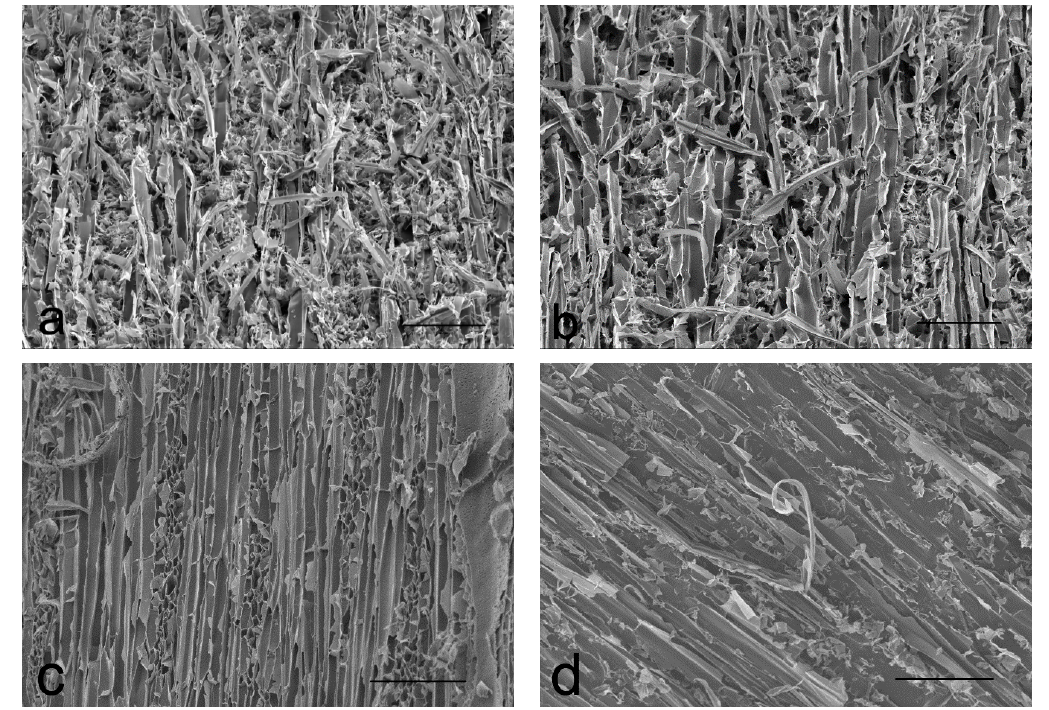
Figure 4. Balsa wood surfaces: ( a ) surface after sanding with 120 and 180 grit aluminium oxide abrasive papers; ( b ) sanded surface after wetting and redrying; ( c ) planed surface after wetting/redrying; and ( d ) loose surface material removed from ( b ) using transparent tape. Scale bars = 200 μ m.